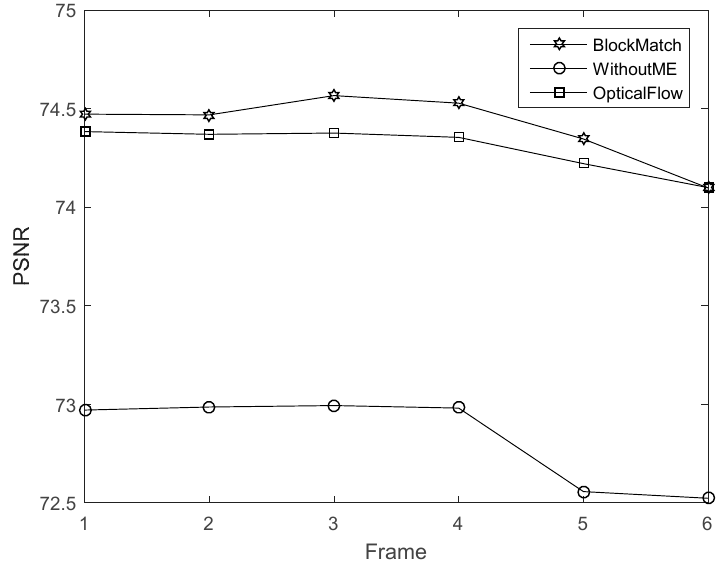
Figure 12. Time cost of the the images reovered by our block matching Scheme, the optical flow and without motion estimation (WithoutME).